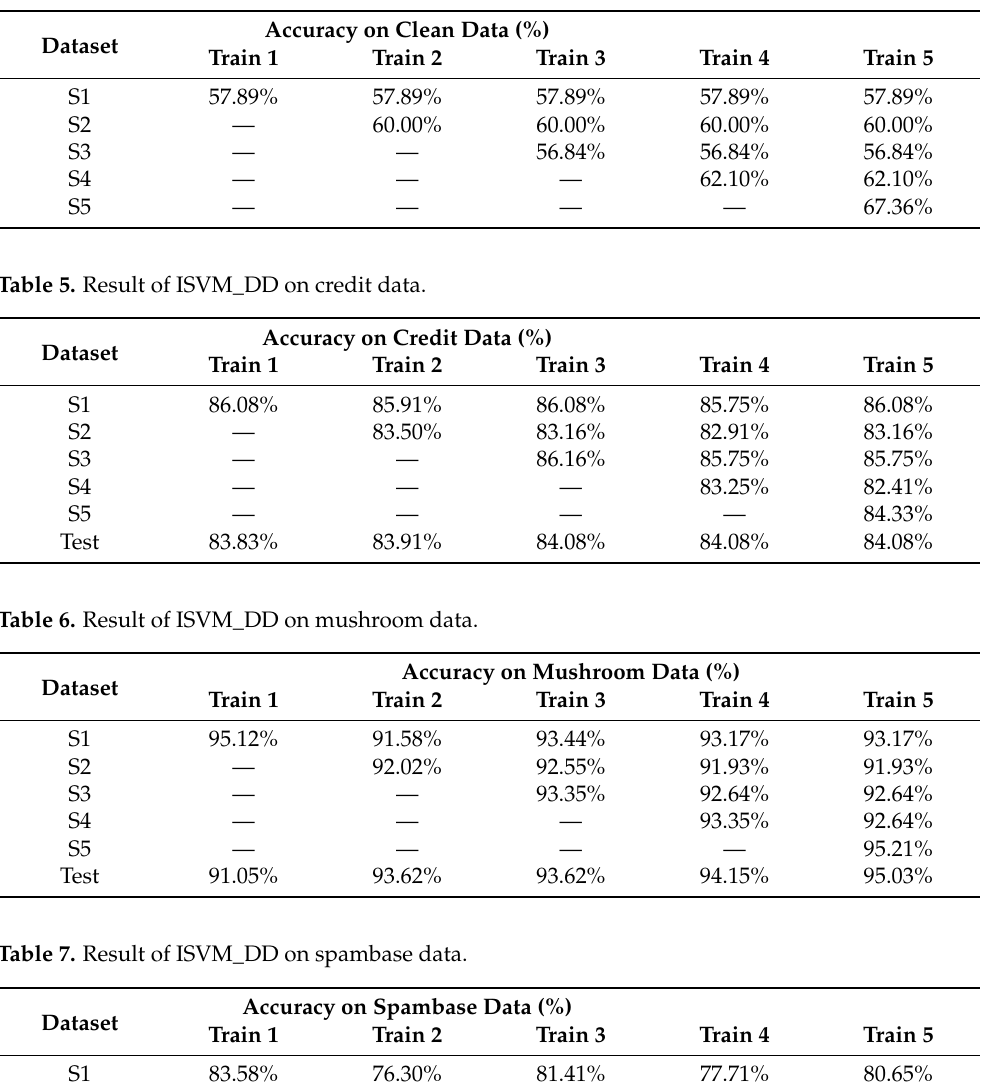
Table 4. Result of ISVM_DD on clean data.